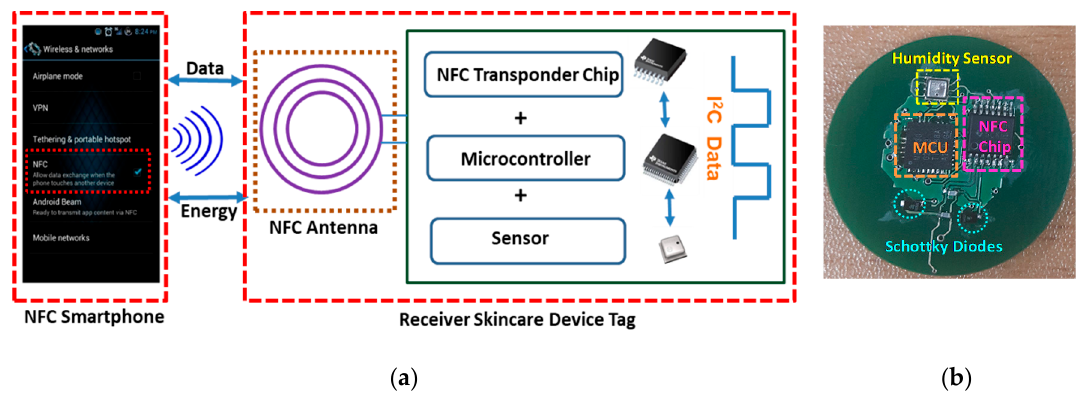
Figure 2. ( a ) Overall structure of the battery-free smart skincare sensor device tag system; ( b ) main components of the skincare device tag.